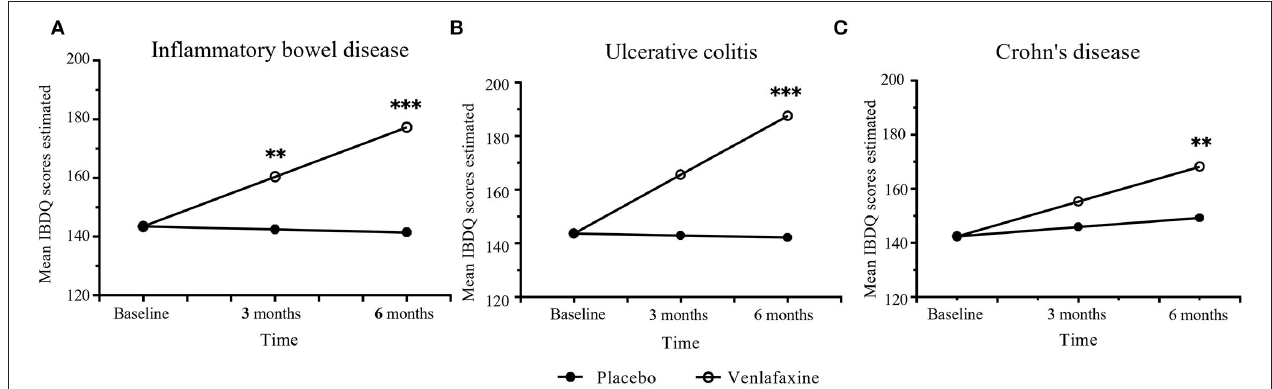
FIGURE 2 | Primary outcomes of mean Inflammatory Bowel Disease Questionnaire (IBDQ) scores between venlafaxine group and placebo group. IBDQ analyzed in entire IBD group (A) , ulcerative colitis (UC) group (B) , and Crohn’s disease (CD) group (C) . Effect size between the venlafaxine group and placebo group is significant with * p < 0.05, ** p < 0.01 and *** p <